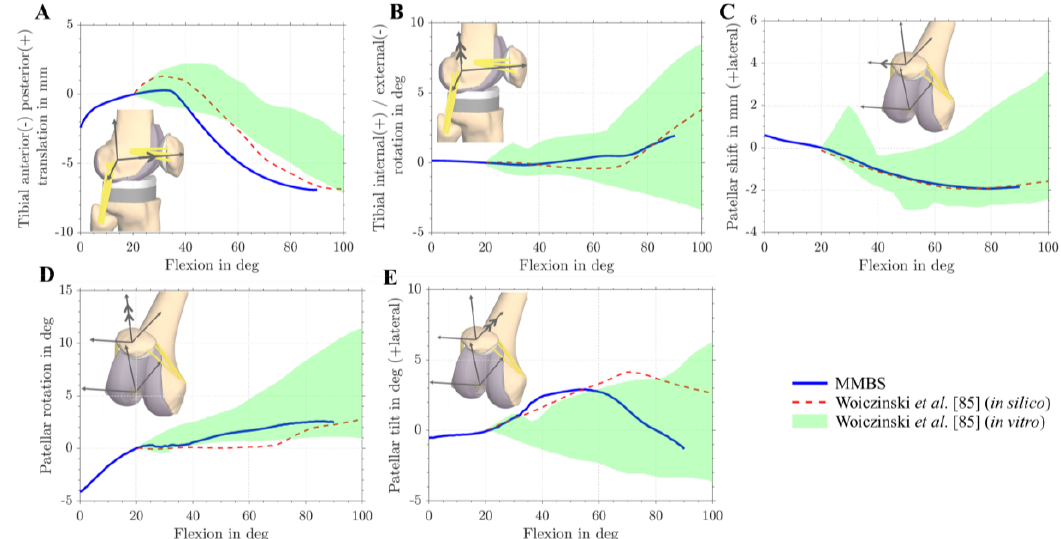
Figure 5. Tibio- and patellofemoral kinematics during dynamic squat motion. In silico (red dotted line) and in vitro (green area) [85] comparison of tibiofemoral and patellofemoral kinematics with kinematics obtained from musculoskeletal multibody simulation (MMBS) model (blue line). Comparison of anterior-posterior tibial translation with reference to the femur ( A ). Tibial internal/external rotation with reference to the femur ( B ). Patellar shift ( C ). Patellar rotation ( D ). Patellar tilt ( E ).